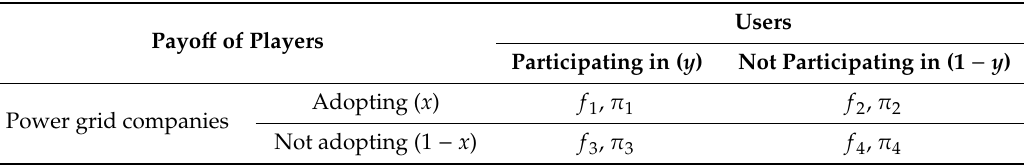
Table 3. Payo ff